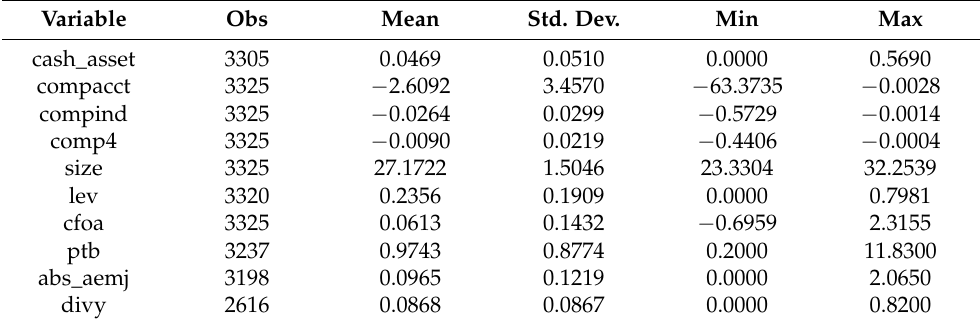
Table 1. Descriptive